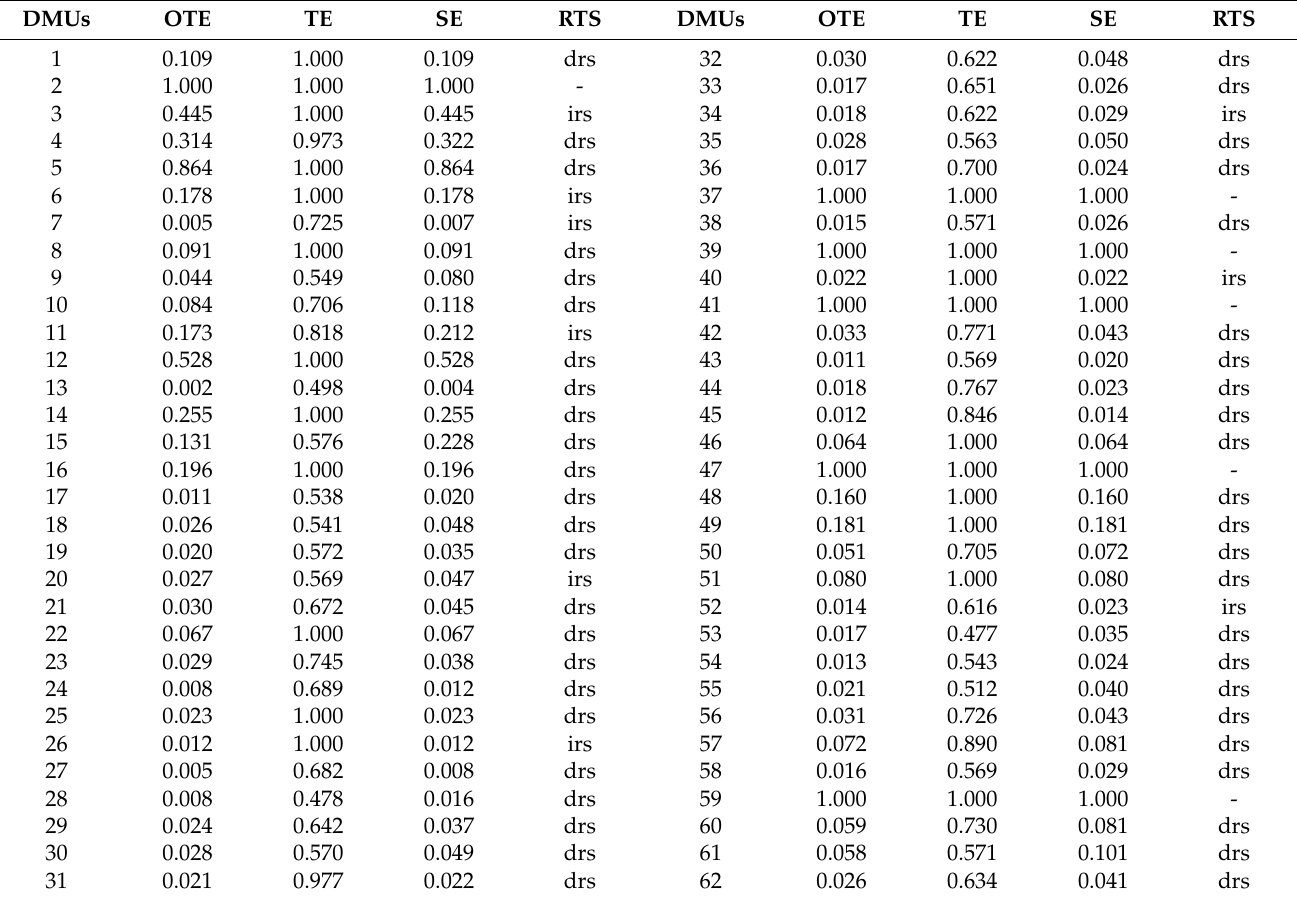
Table 3. Efficiency value of each retail